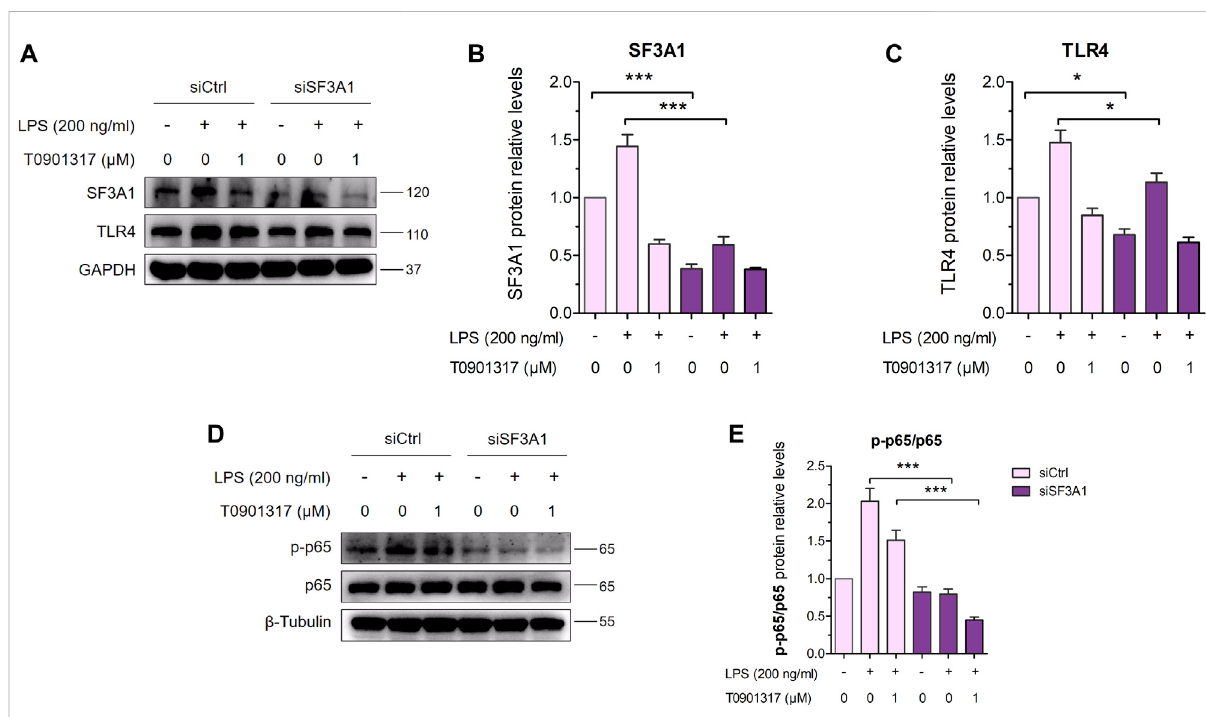
FIGURE 7 Inhibition ofSF3A1synergistically attenuates in fl ammationinTLR4-mediatedNF- κ Bpathway. (A – C) RAW264.7 macrophages weretransfected with negative control siRNA or SF3A1 siRNA for 24 h, followed by treating with or without LPS (200 ng/mL) and T0901317 (0 or 1 μ M) for 18 h, then protein levels of SF3A1 and TLR4 were measured by western blot, normalized to GAPDH. (D,E) RAW264.7 macrophages were transfected with negativecontrolsiRNAorSF3A1siRNAfor 24 h, followed bypretreatingwith T0901317 (0or1 μ M) for18 h,then stimulated withorwithoutLPS (200 ng/mL)for1 h.Phosphorylatedp65andp65proteinlevelsweremeasuredbywesternblot.Phosphorylatedp65proteinlevelwasnormalizedto p65. Similar results were obtained in three independentexperiments. Values are expressed as means ± SEM and were analyzed by one-way ANOVA. * p < 0.05, *** p <